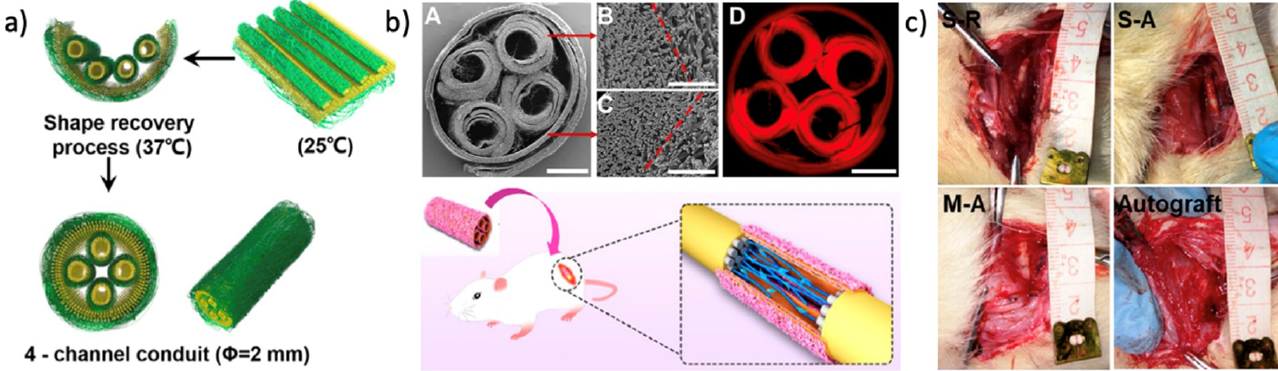
Figure 7. ( a ) Self-forming of the nerve conduit based on a shape memory nanofibrous scaffold; ( b ) the cross-section im-ages of the SMP multichannel nerve conduit ( A – C are SEM images showing the aligned and random fiber layers, and D is fluorescence micrograph of the conduit); ( c ) photographs of nerve conduit transplantations at 12 weeks of postsurgery (Reprinted with permission from ref. [154]. Copyright 2020 American Chemical Society). Table 1. A summary of recent works on SMP fibrous structures for biomedical applications.